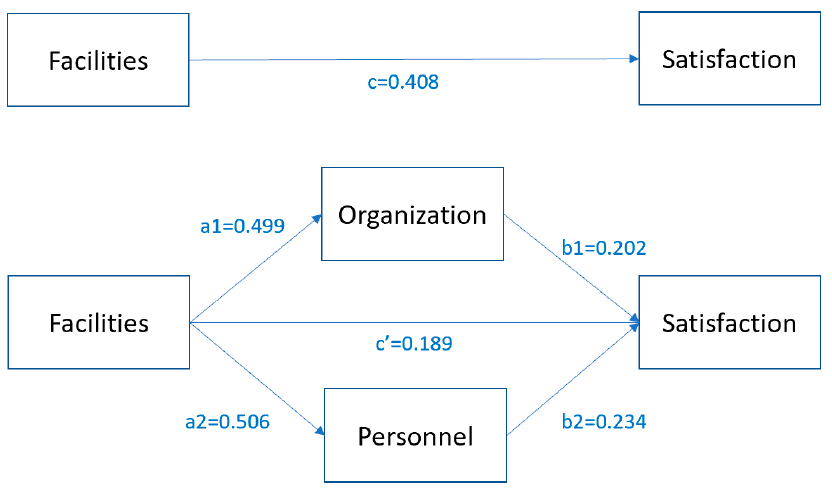
Figure 1. Definitive model.